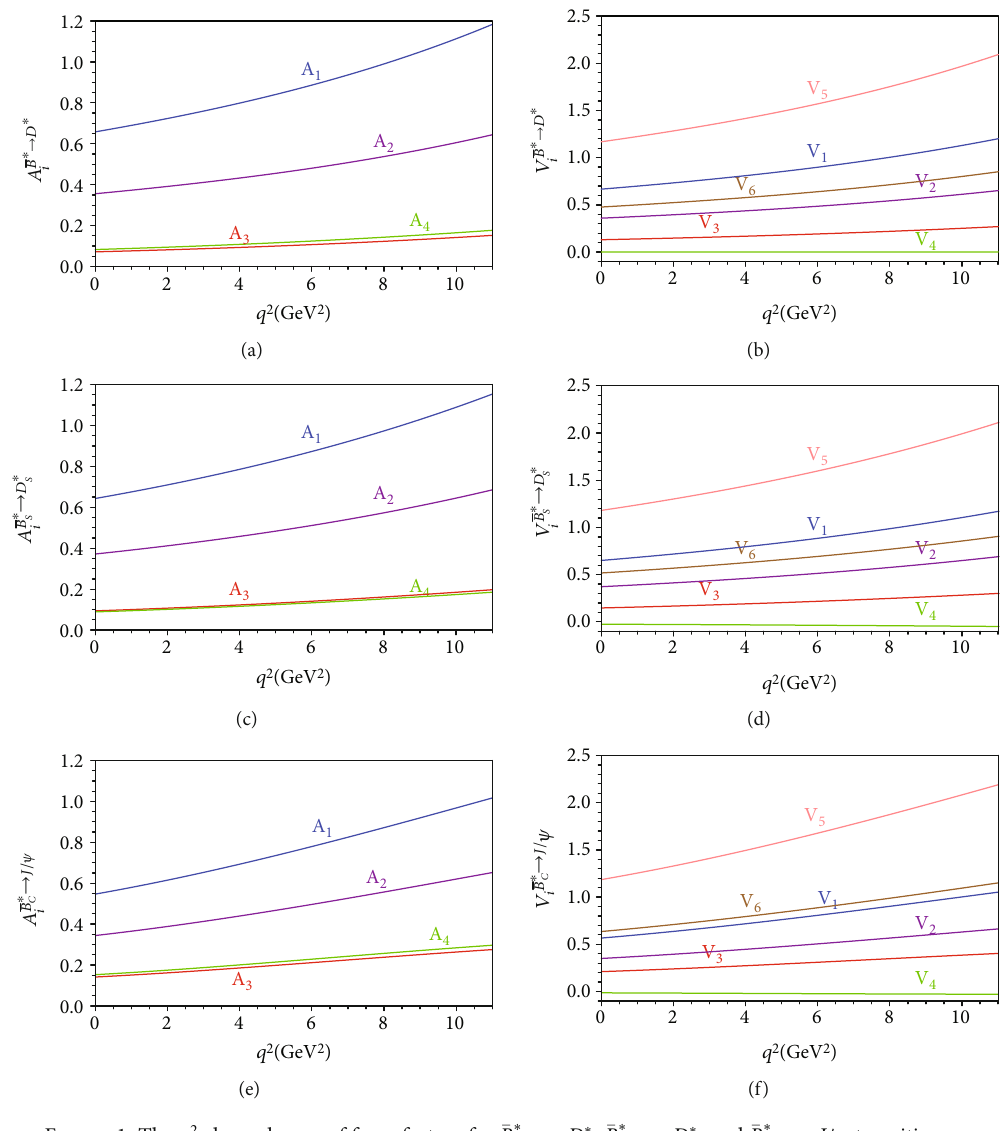
Figure 1: The q 2 -dependences of form factors for (cid:1) B ∗ ⟶ D ∗ , (cid:1) B ∗